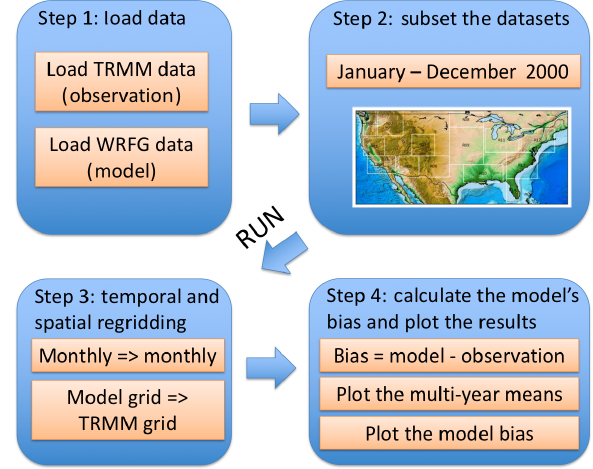
Figure 3. The four steps of model evaluation included as a CLI example of